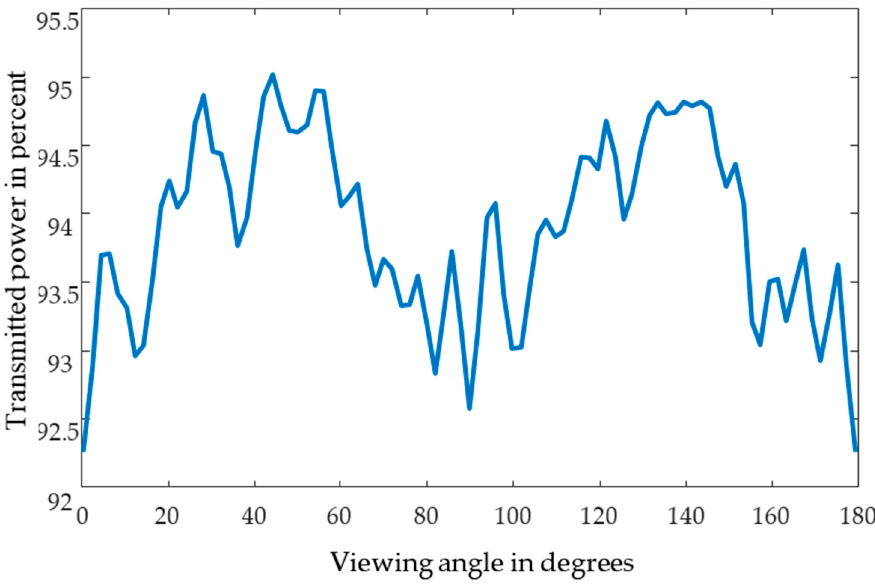
Figure 6. Plot of the Celes -simulated transmitted intensity at different viewing angles of an arbitrary cluster of 500 spheres.